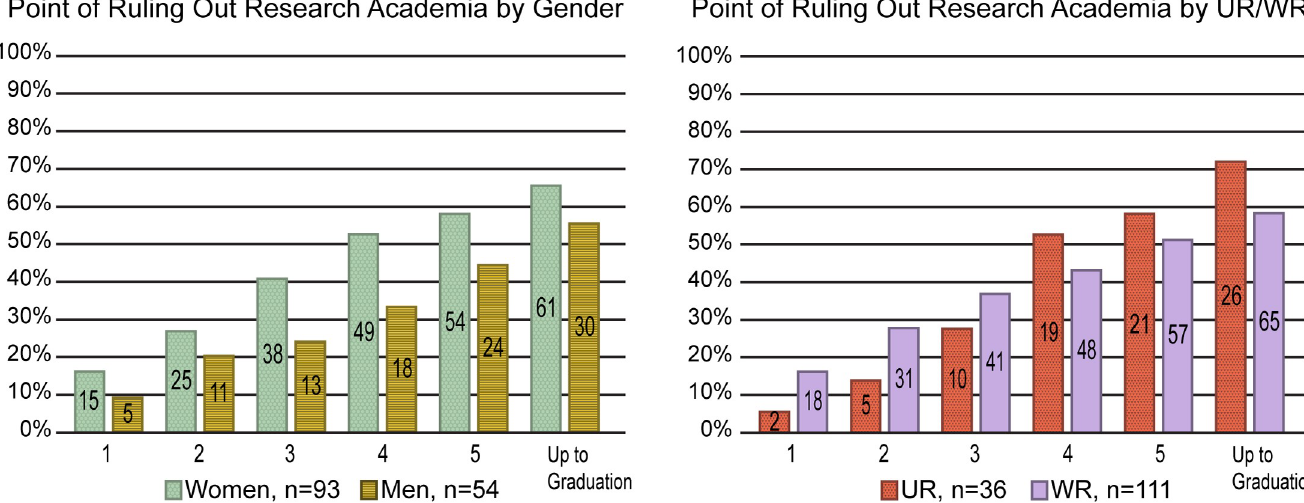
Fig 3. Point of ruling-out an academic research career. Fig 3 shows data for the 91 individuals who ruled out an academic research career during their PhD training by gender and UR/WR status. The charts illustrate the year in which a participant ruled out this career option. The data reflected in the bars are cumulative and display the total number and percentage of participants from each population who ruled out an academic research career at or before the time point indicated. The start of the fifth year of the PhD was the first year in which anyone in the study graduated and is the last real time point reflected. The denotation “up to graduation” refers to any decision-making that occurred between the end of the fifth year and graduation. Note, this figure reflects subjects who definitively ruled out academic research and does not include anyone who had an academic research career as a mixed top choice at graduation. There are no significant differences (Pearson’s chi-squared tests, p < .05) between men and women nor between UR and WR participants as to when an academic research career was ruled out.